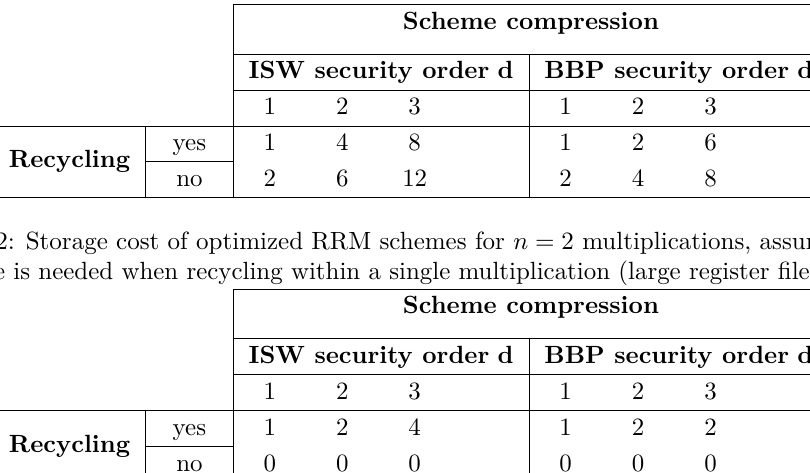
Table 1: Randomness cost of optimized RRM schemes for n = 2 multiplications.